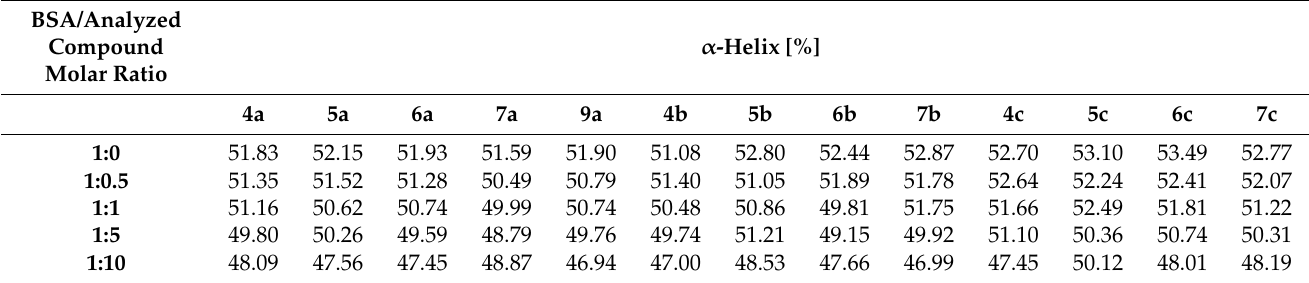
Table 5. The values of the calculated α -helix(%) for BSA with the absence and presence of all analyzed compounds. BSA/Analyzed